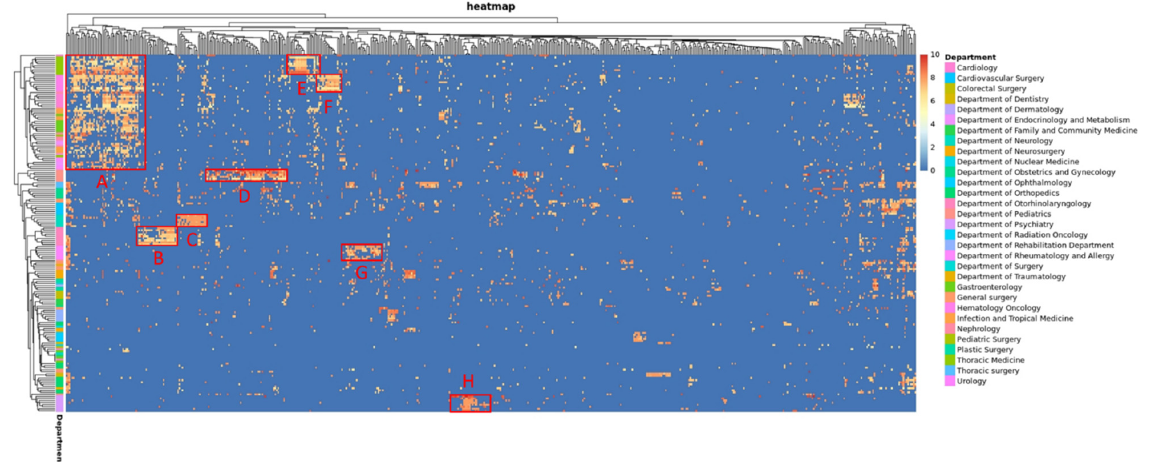
Figure 2. Heat map of medical record scores from scoring and scored physicians. X -axis: physicians who wrote the medical records; Y -axis: scoring physicians and their departments. A redder grid means record scoring physicians give a higher score to record writing physicians. There are clusters in some areas; thus, we put out some blocks and observe the block (A to H) characteristics in Table 4. Table 3. The difference between the original AI/LMM-modified score and the expert score.